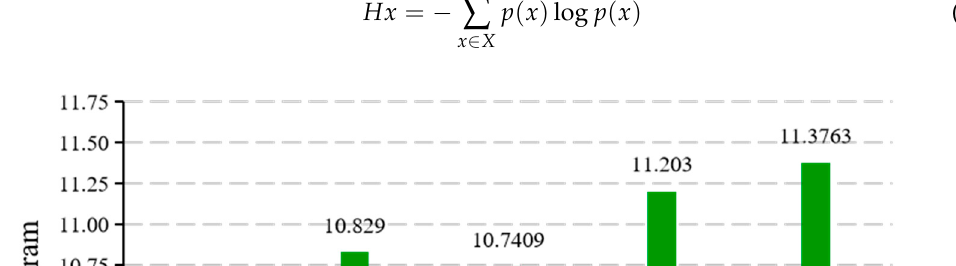
number of groups was 50.